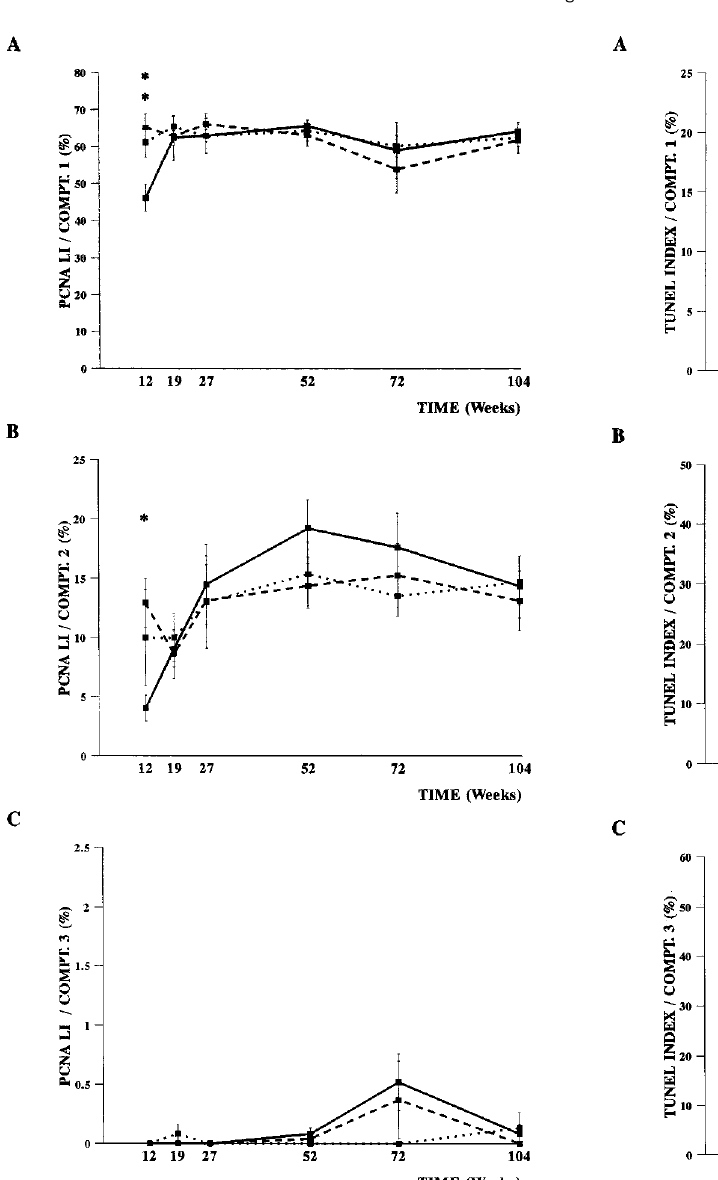
Fig. 3. TUNEL Index in compartment 1 (A), compartment 2 (B), and compartment 3 (C). (Control Diet, CD: ___; Western Diet A, WD A: (cid:1)(cid:1)(cid:1) ; Western Diet B, WD B: ----; vertical bars: SEM; * P < 0 :